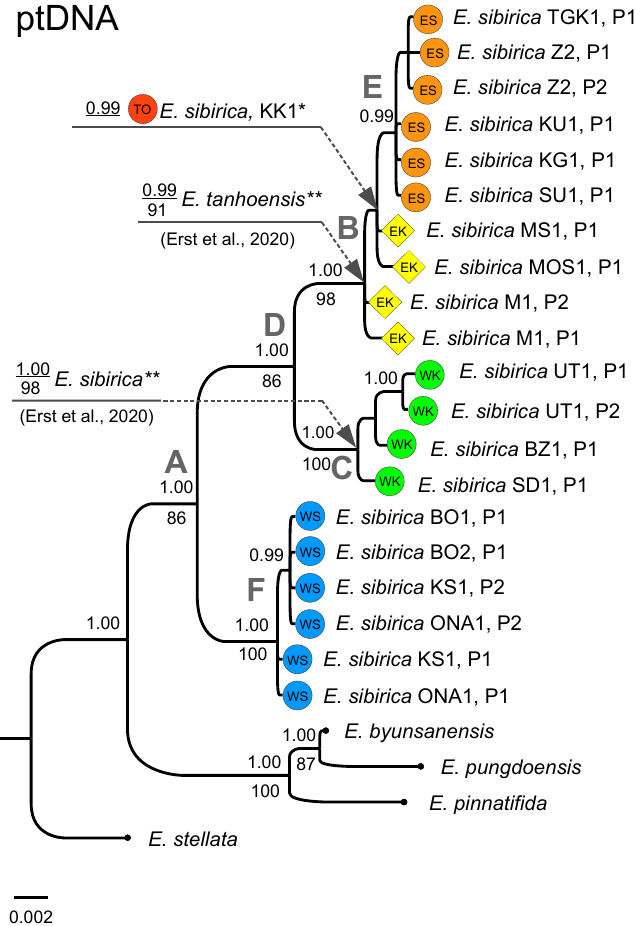
Figure 3. BI phylogram based on ptDNA. The color patterns and names correspond to those in Figure 1. Posterior probabilities ≥ 0.95 are indicated above branches, Bootstrap values for the corresponding clades on the ML tree (if relevant) below the branches. Capital letters at the nodes correspond to the groups discussed in the text. The scale bar indicates the number of expected changes (substitutions or/and indels and inversions) per site corresponding to a unit of branch length. *—branch position was inferred using the trnL + trnL-trnF dataset only; **—branch positions were inferred from the independent analysis based on the alignment with completely deleted multiple indel regions and not including the binary matrix (see Section 2.4).